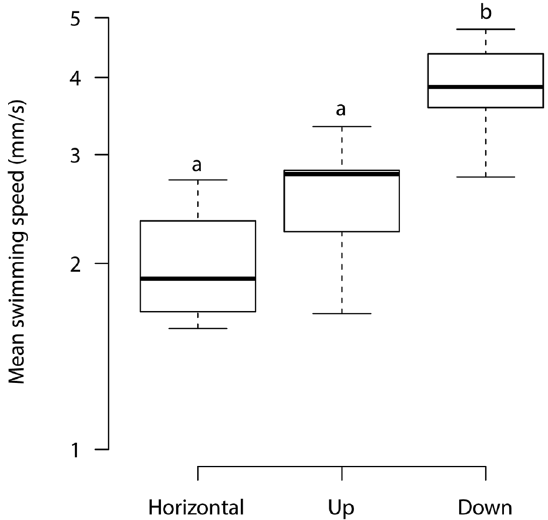
Figure 2. Mean larval swimming speeds in three different directions, horizontal, vertical and downward (i.e., gravity assisted), taken from nine studies representing over 450 individual measurements of swimming speeds